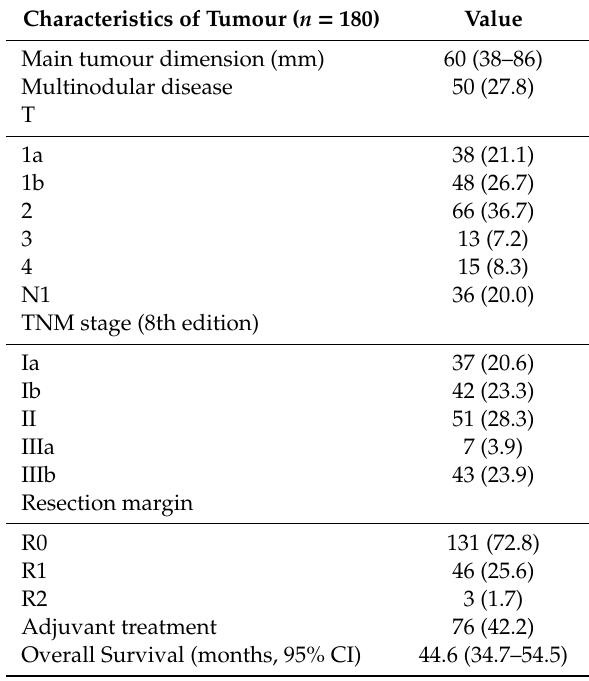
Table 2. Tumour staging in the whole study population. Continuous variables have been reported as median (interquartile